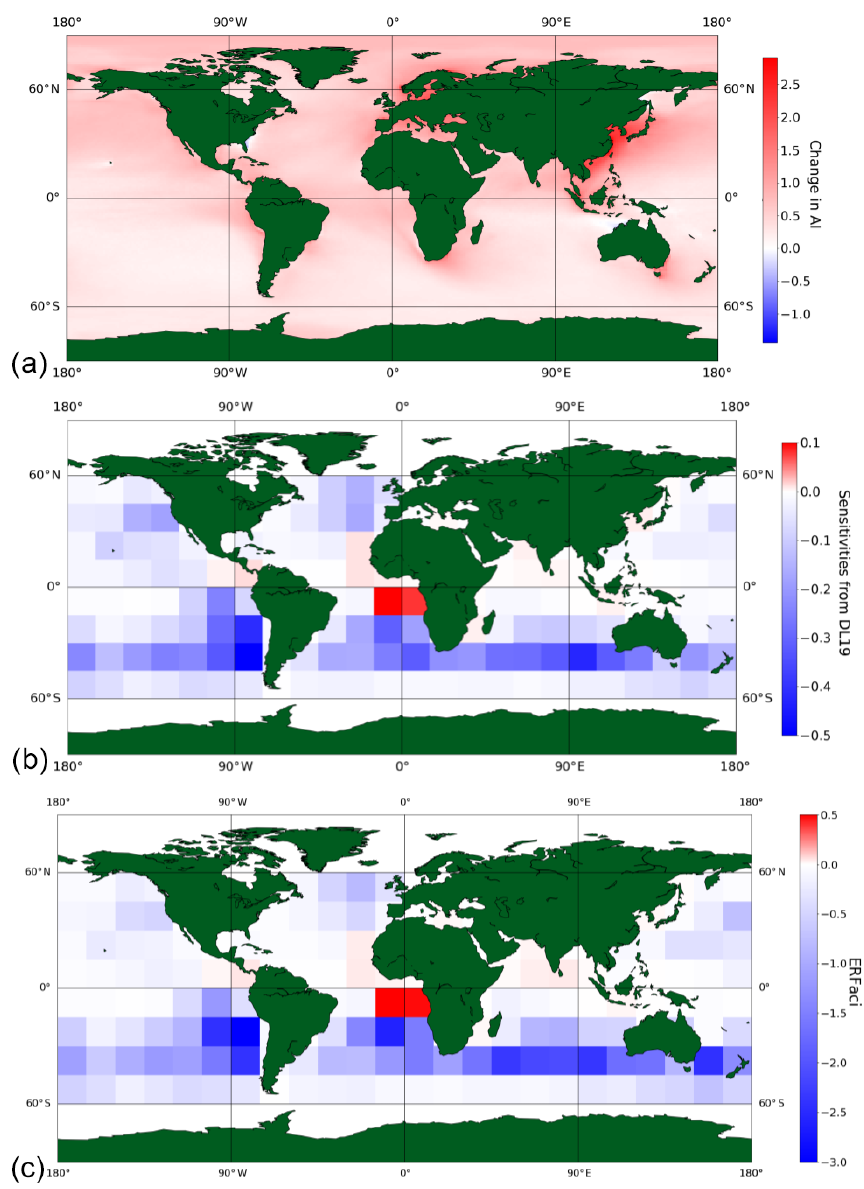
Figure 1. (a) The change in aerosol index from SPRINTARS from the preindustrial to present day, (b) ∂ CRE associated ERFaci warm found using Eq. (2) found with constraints on LWP, EIS, and RH 700 ( − 0 . 32 ± . 16Wm − 2 ) using susceptibilities from DL19 (b) without areal